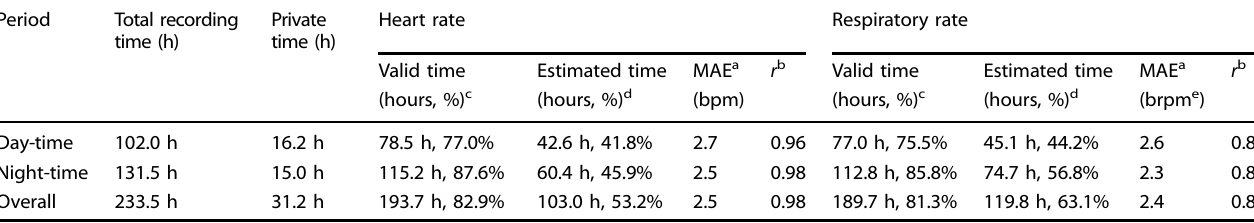
Table 3. Summary of vital-sign estimation results for the day-time and night-time periods.